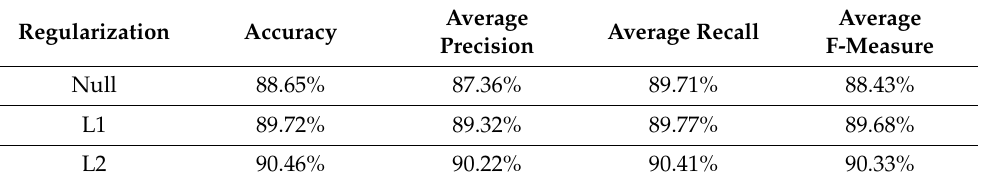
Table 3. The performance of the OSR model based on confidence score.